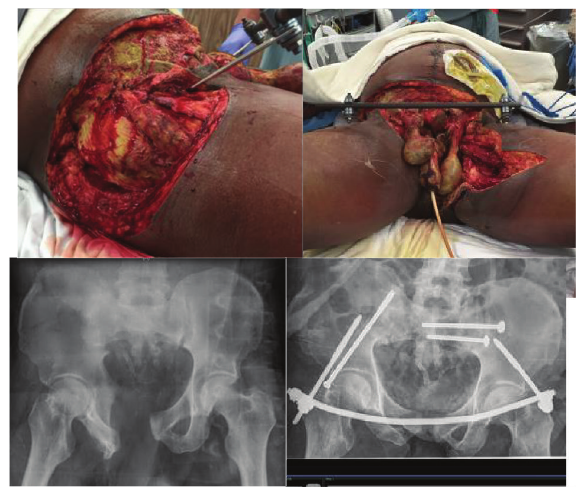
Figure 5: This is a 62-year-old male who was involved in a motor vehicle accident. His open injury was missed initially when he arrived in extremis and developed a massive pelvic soft tissue infection requiring debridement over the first 3 days.